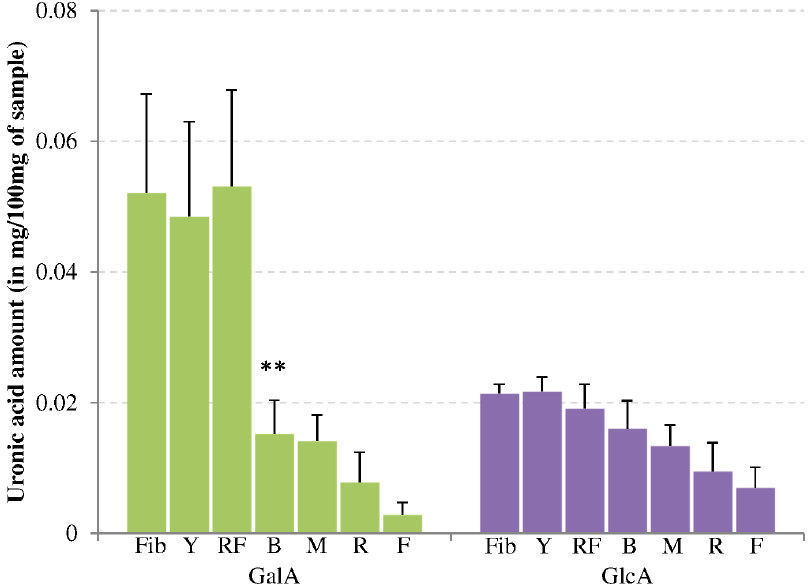
Fig. 1. Uronic acid content of processed cotton samples. Extracted galacturonic acid (GalA) and glucuronic acid (GlcA) from powdered textile processing samples; Fib 5 fibre, Y 5 yarn, RF 5 raw fabric, B 5 bleached/scoured fabric, M 5 mercerized fabric, R 5 ready-to-dye fabric, and F 5 finished fabric. Error bars represent standard deviation (n 5 3). ** indicates significant difference between bleached and raw fabric samples at p , 0.01.